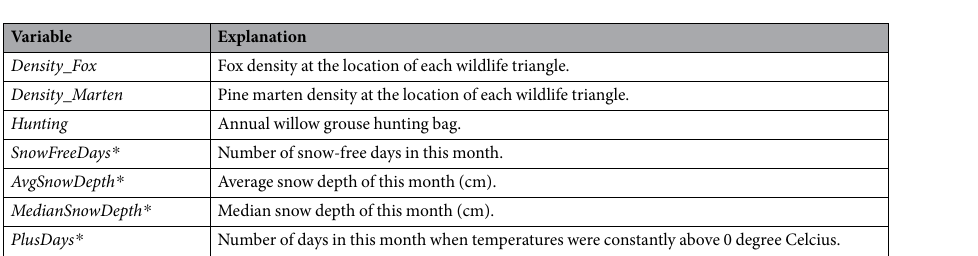
Figure 3. Average number of snow-free days in October, November, April and May in the study area between 1996 and 2016 (thin lines with points), and the smoothed average trend over the years (bold lines with grey polygon that depicts 95% confidence interval for the mean).